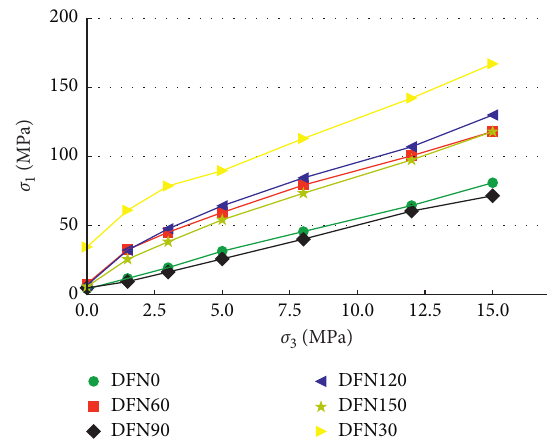
Figure 15: Peak strength envelope curves when the specimen size is 5 × 10m.